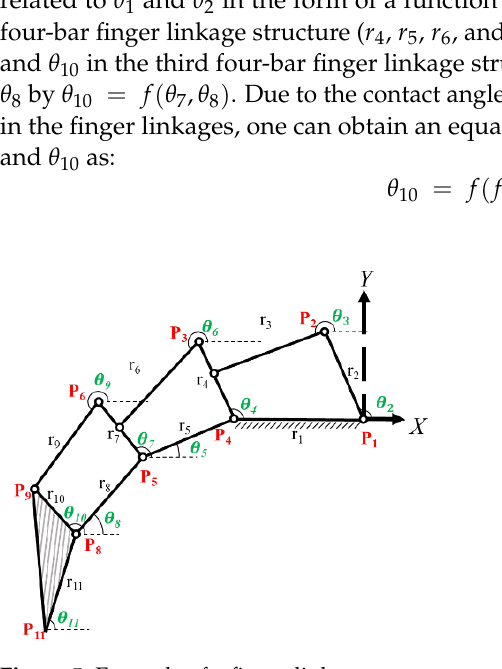
Figure 5. Example of a finger linkage